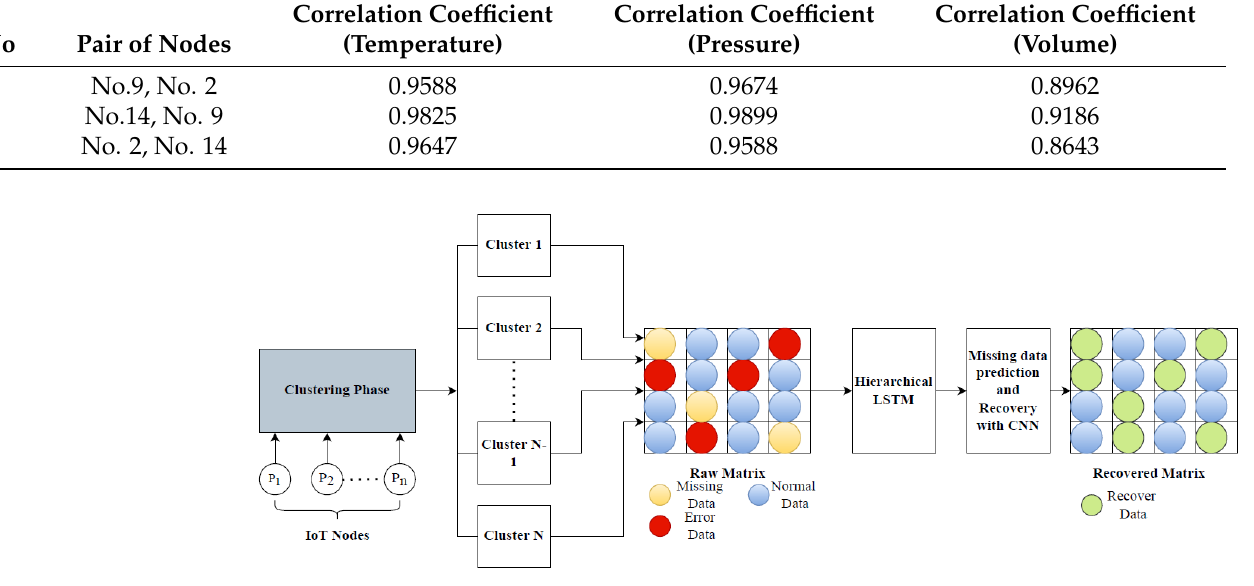
Figure 2. Functional block diagram of proposed